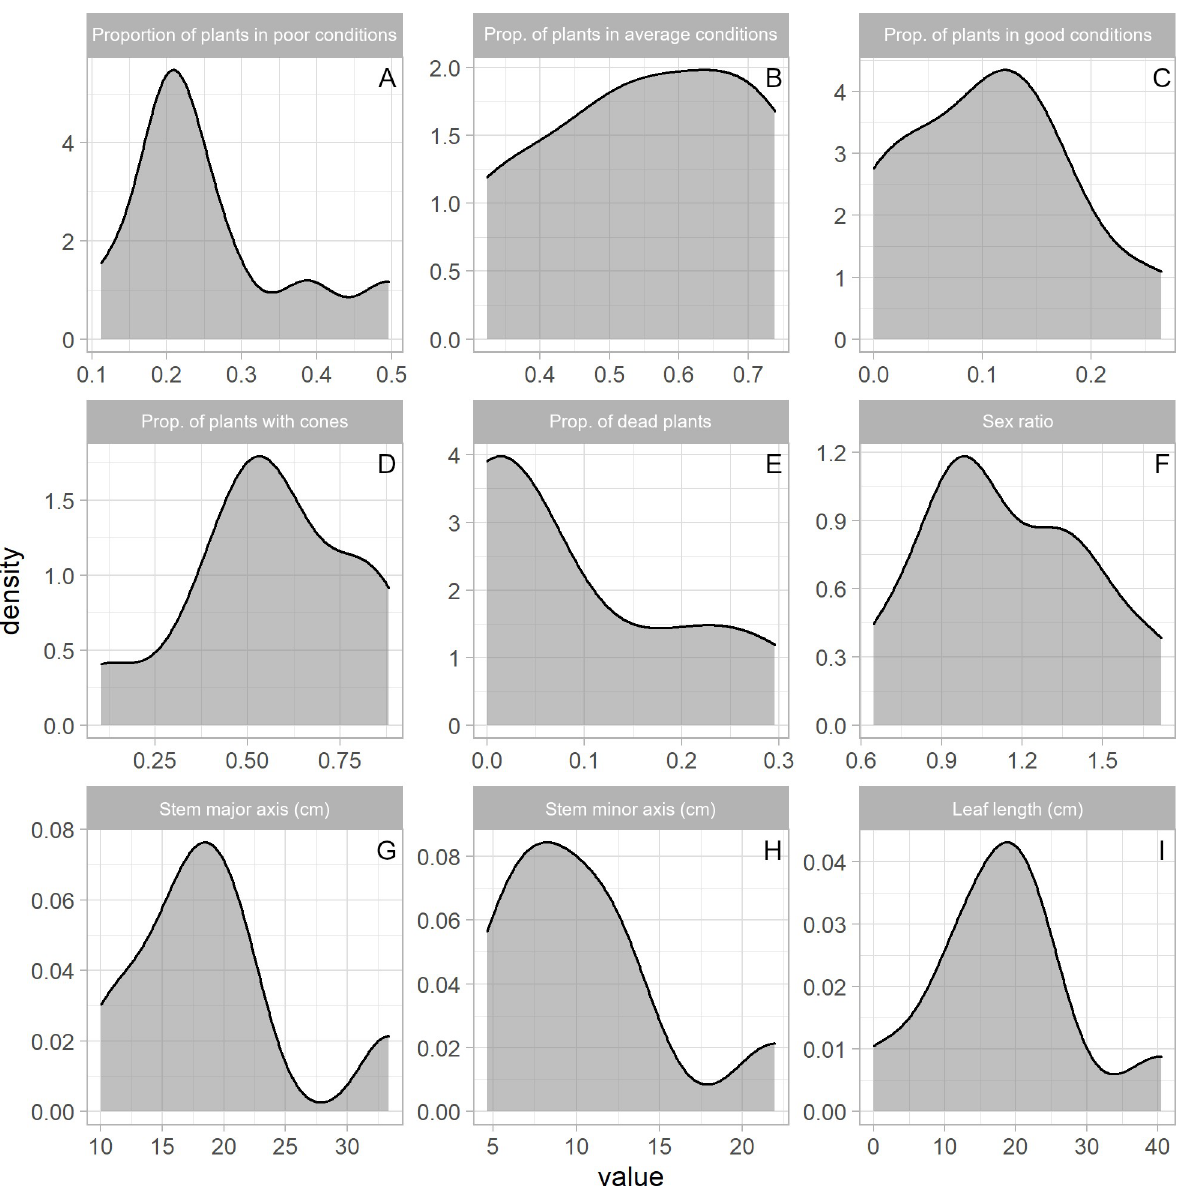
Fig 3. Observed variability of plant traits. Density plots of measured values for: proportion of plants in poor conditions (A), proportion of plants in average conditions (B), proportion of plants in good conditions (C), proportion of plants with cones (D), proportion of dead plants (E), sex ratio (F), stem major axis (G), stem minor axis (H), and leaf length (I). Density plots use kernel density estimates to show the probability density function of the variables.